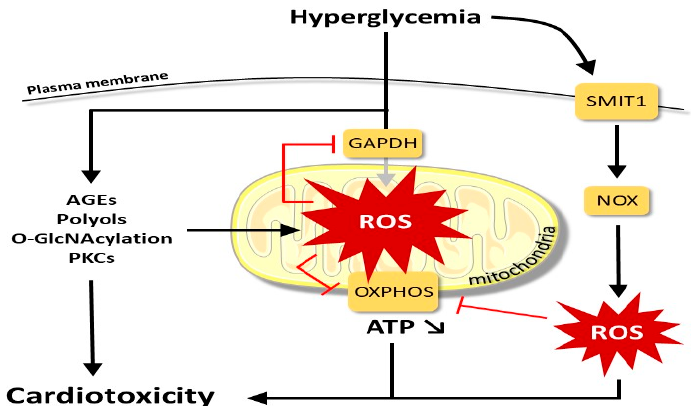
Figure 2. Main factors leading from hyperglycemia to cardiotoxicity (for acronyms see the list of